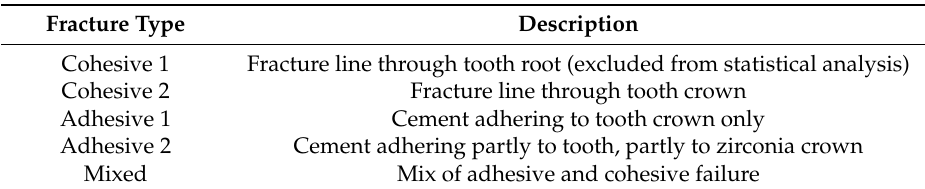
Table 3. All classified fracture types.